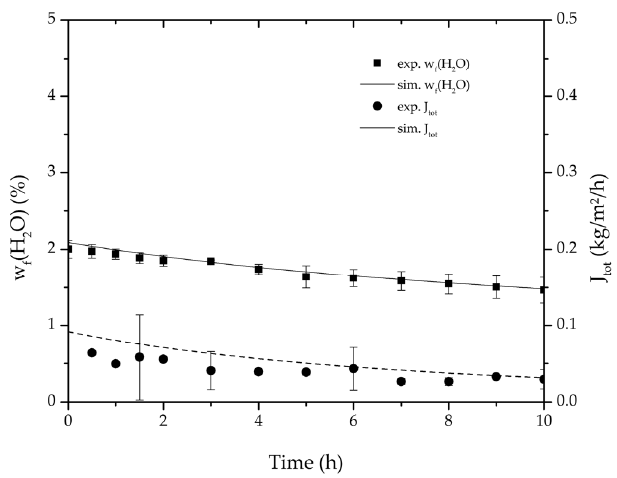
Figure 7. Average water mass fraction of the feed and total permeate flux of the thrice-repeated centre point experiments over the experimental duration for the binary system ethyl acetate/water. The error bars represent the standard deviation, the line the simulation result. Table 6. Determined permeance data for the two binary systems by a nonlinear least squares regression, minimizing the weighted square error between experiments and simulation. For the simulation of the ternary system, the organic solvent permeance data was adopted from the binary data. The water permeance data for the ternary simulation was adopted from the ethyl acetate/water data. Exp.